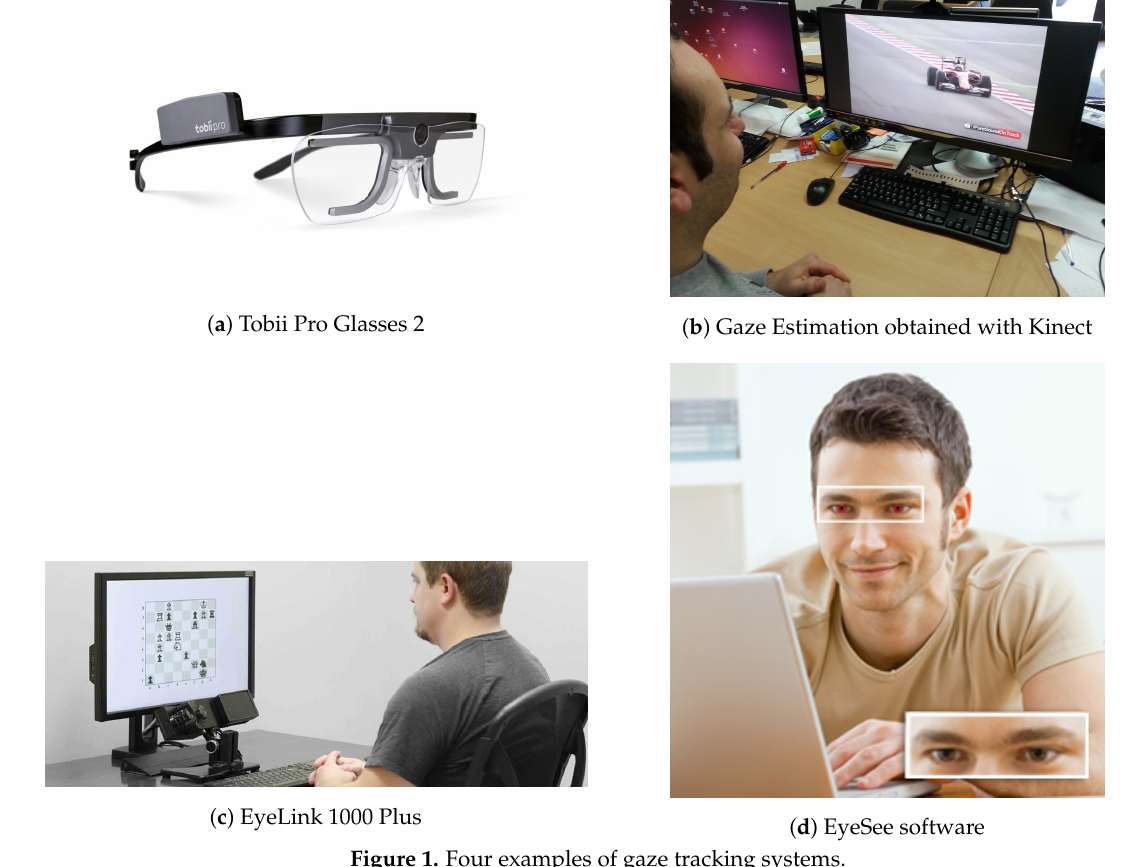
Figure 1. Four examples of gaze tracking